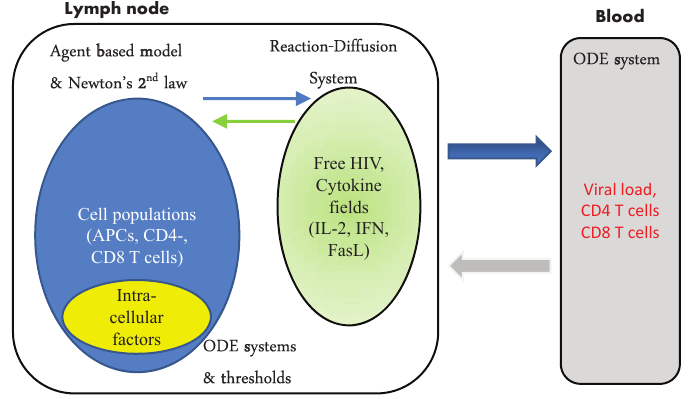
Figure 1. General structure of the multiscale model of HIV